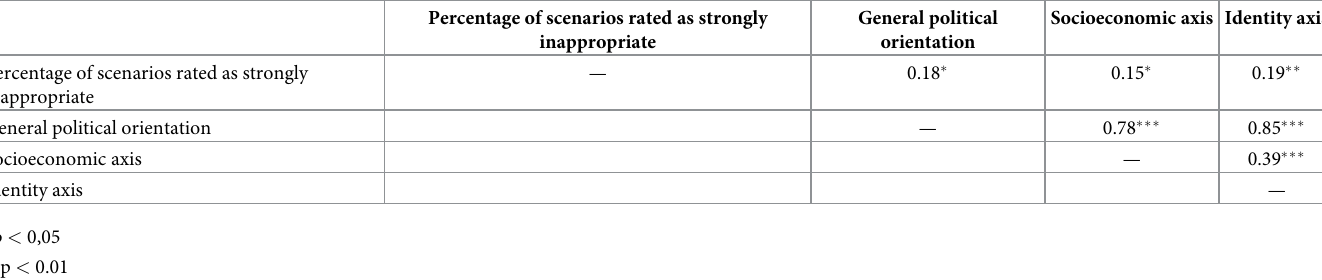
Table 4. Correlations between political orientation scores and sensitivity to social norm